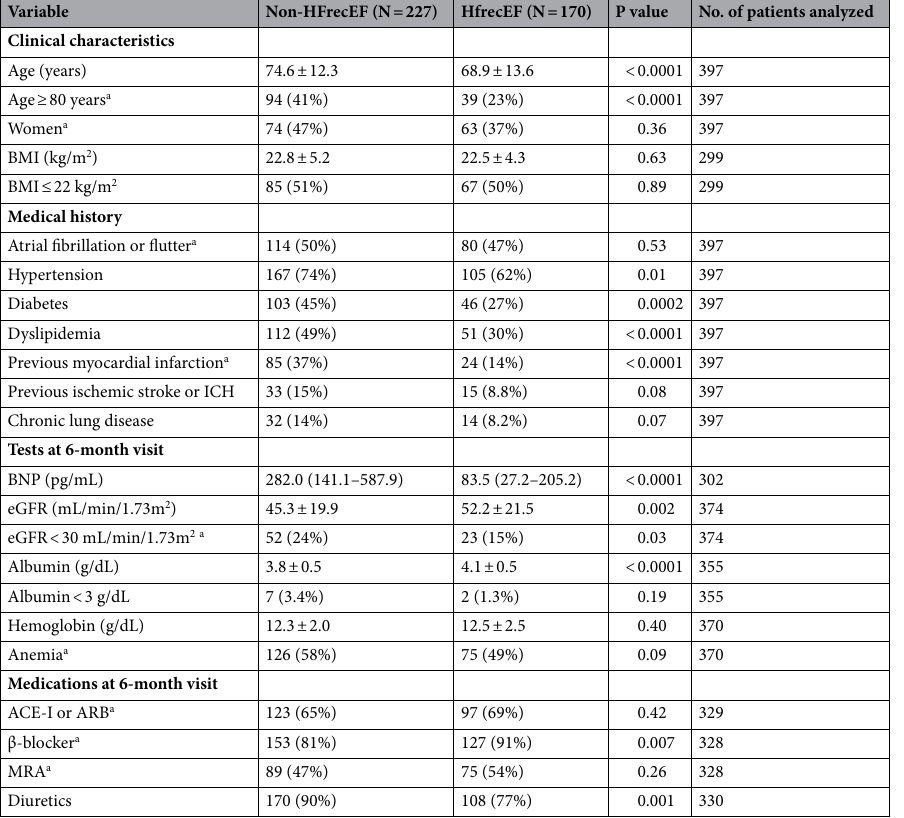
Table 1. Patient characteristics at 6-month echocardiographic follow-up. Diuretics included loop diuretic, thiazide and tolvaptan. a Risk-adjusting variables selected for the Cox proportional hazards regression model. HFrecEF, heart failure with recovered ejection fraction; BMI, body mass index; ICH, intracranial hemorrhage; BNP, brain natriuretic peptide; eGFR, estimated glomerular filtration rate; ACE-I, angiotensin-converting enzyme inhibitor; ARB, angiotensin-receptor blocker; MRA, mineralocorticoid receptor